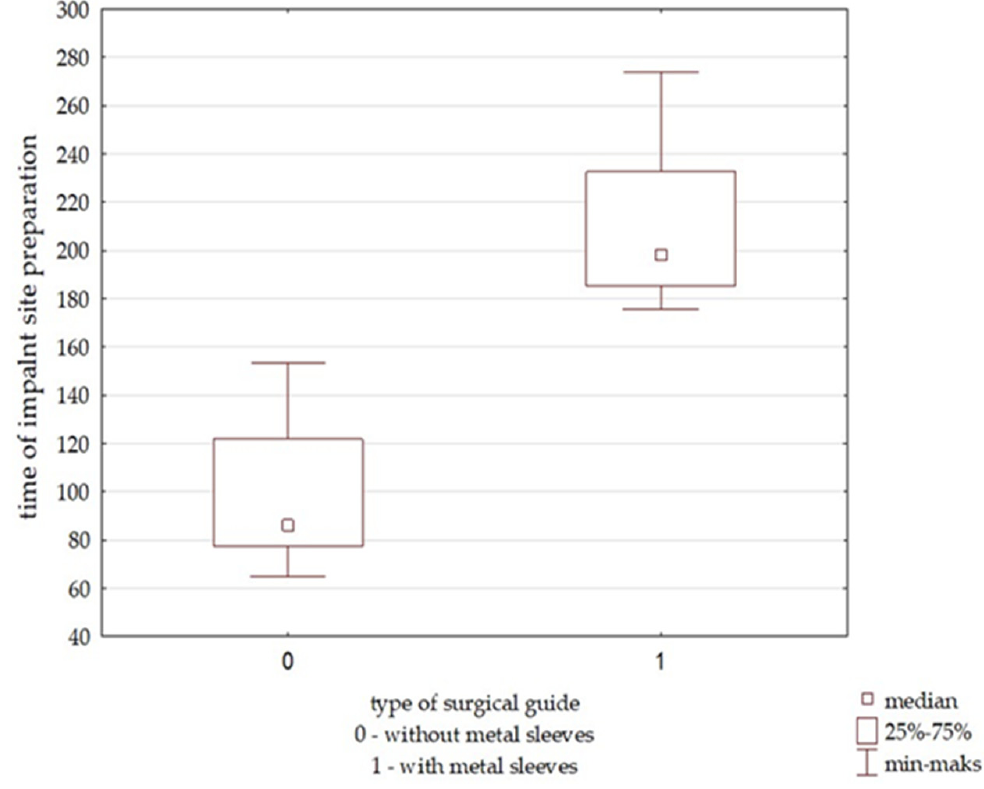
Figure 1. Comparison of data distribution based on type of surgical guide: group 0, without metal sleeves, OGK; group 1, with metal sleeves, GKT.